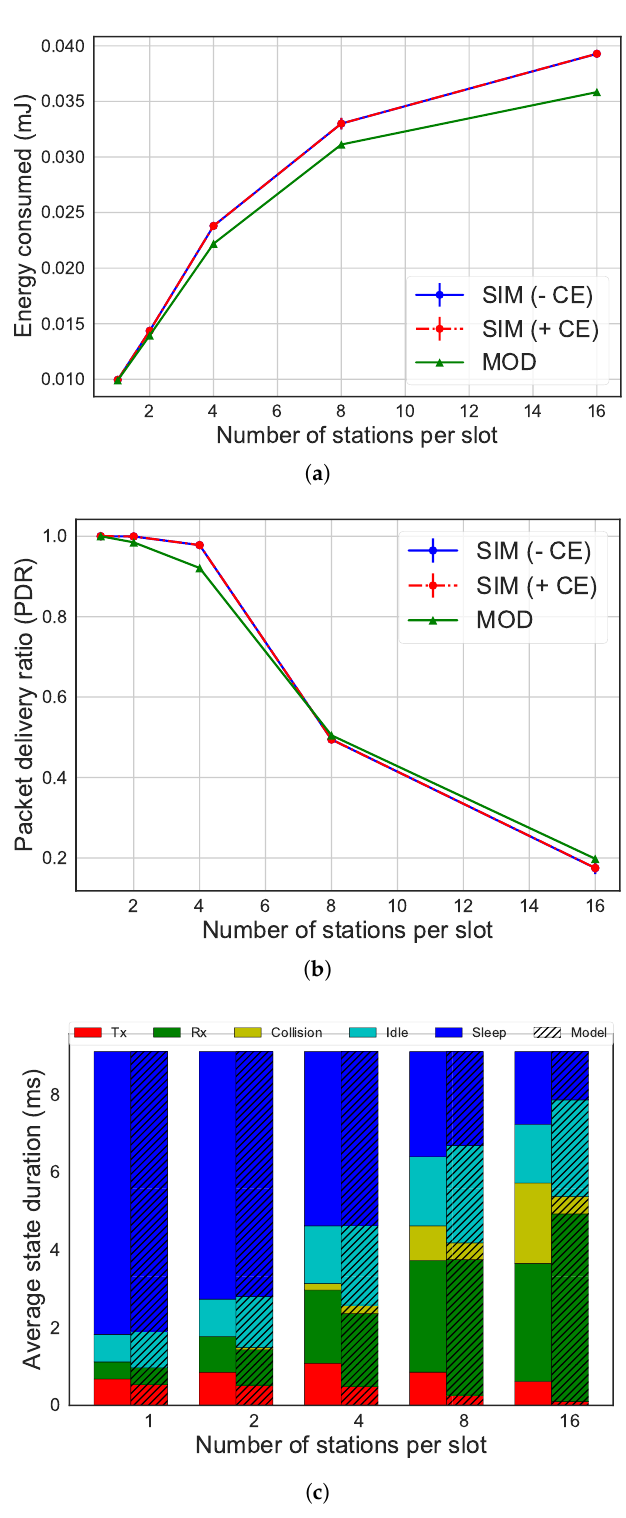
Figure 6. Comparison of results between simulation without CE (SIM − CE) and with CE (SIM + CE) and analytical MOD for 4 Mbps, 64 bytes as payload size and 11264 µ s as slot duration. ( a ) average energy consumption per STA; ( b ) PDR; ( c ) radio state duration per